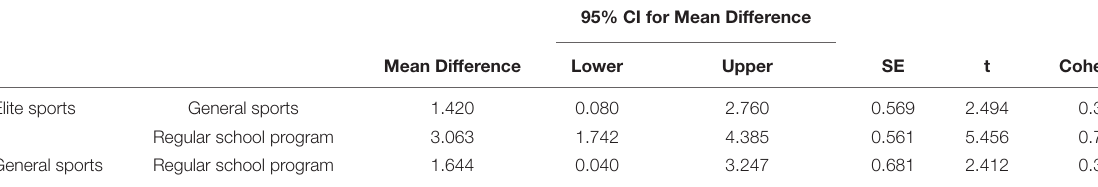
TABLE 6 | Post hoc comparisons of the NCI and educational